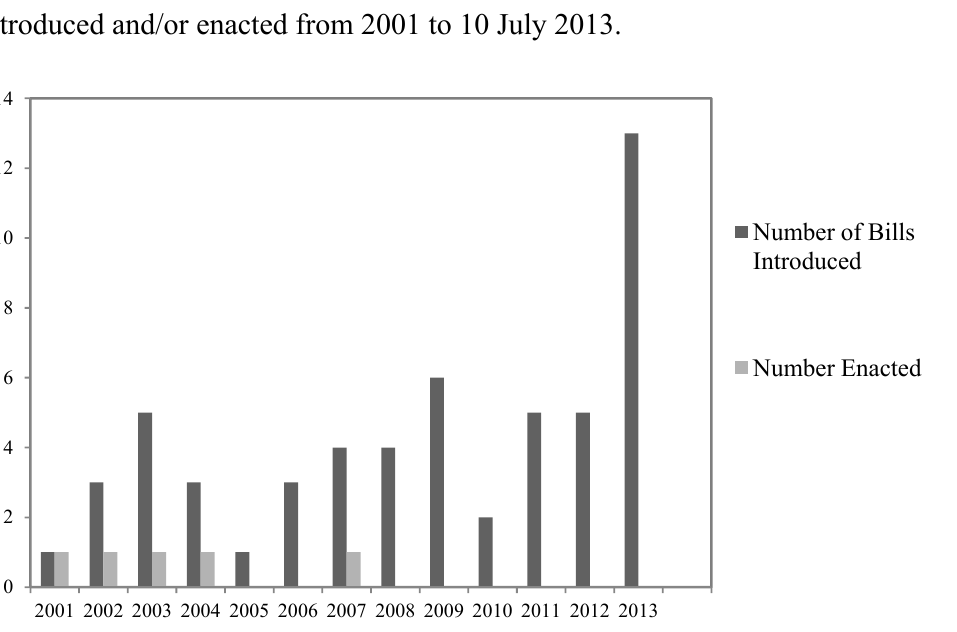
Figure 1. Number of bills involving timber sales that included bark beetle control that were introduced and/or enacted from 2001 to 10 July